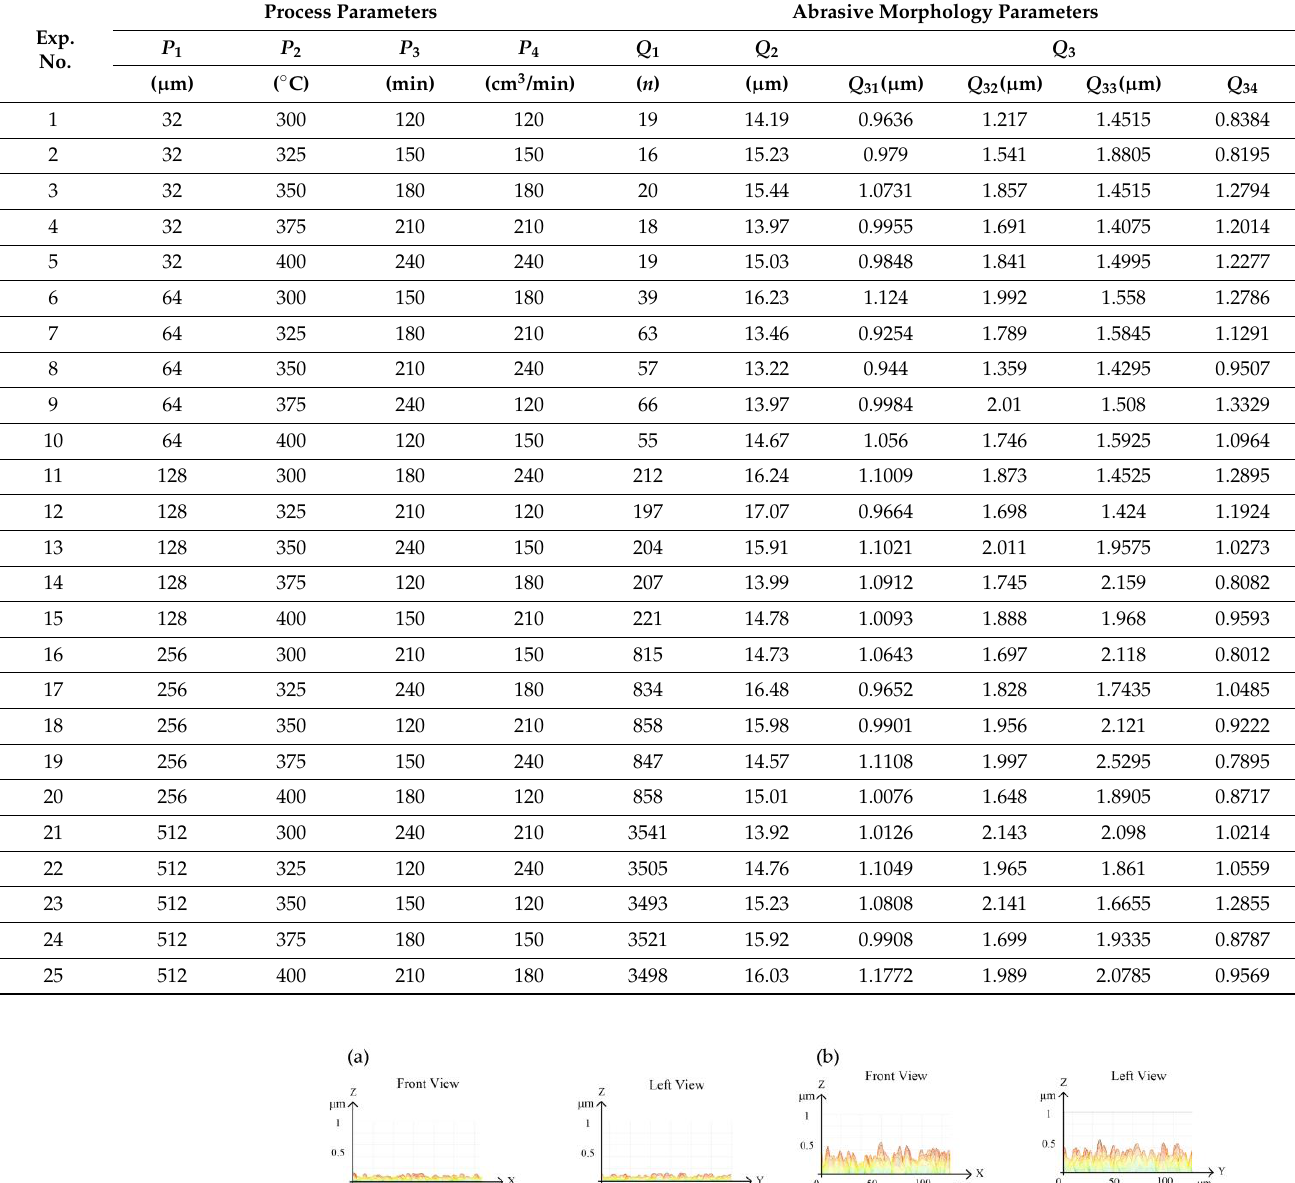
Table 2. Taguchi L25(54): array